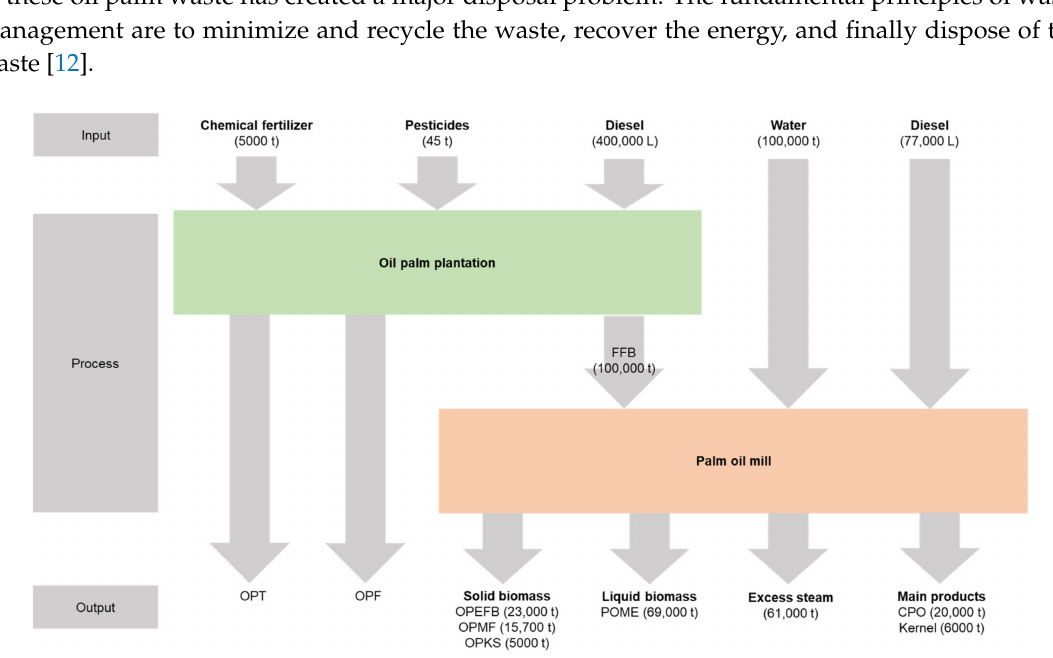
Figure 2. Material flow in the palm oil mill showing the production of oil palm empty fruit bunch (OPEFB), oil palm mesocarp fiber (OPMF), oil palm kernel shell (OPKS) and palm oil mill effluent (POME) from fresh fruit bunch (FFB). Units represent t: tonnes and L: litre. Data adapted